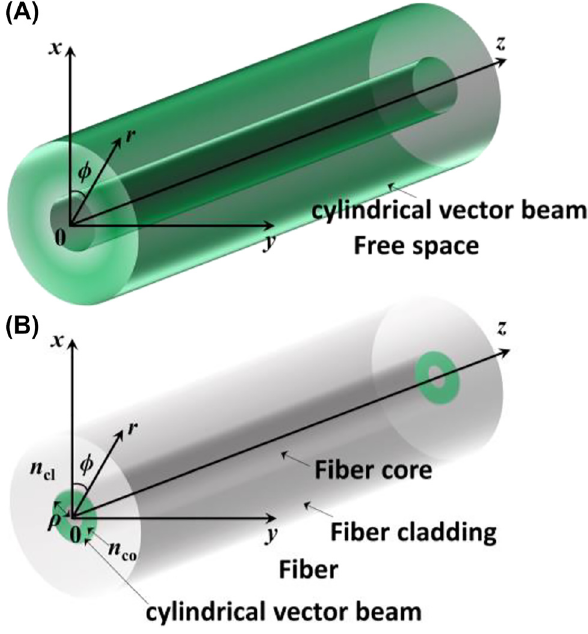
Figure 1: Diagrams of CVBs. (A) Diagram of CVB in free space. (B) Diagram of CVB in